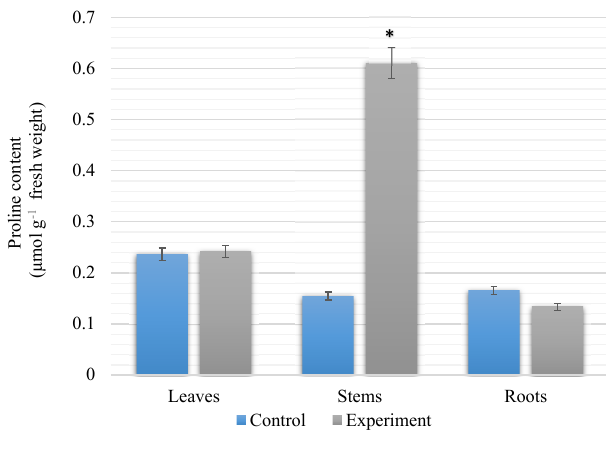
Figure 2 Content of proline in Salix viminalis under salinity condition (field condition, 120 days of growth). * Significant difference compared with the control, p < 0.05.